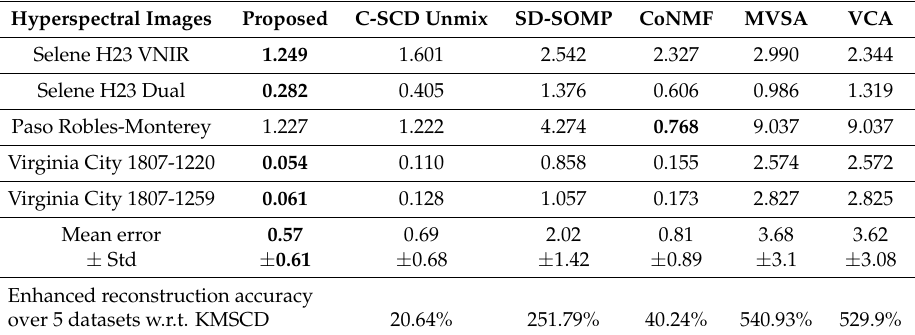
Table 2. Mean DL1NE on various hyperspectral scenes.